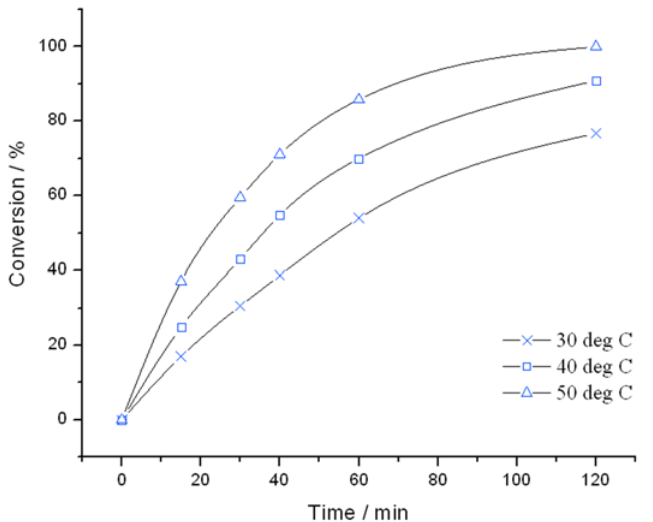
Figure 1. Time online analysis of allyl alcohol epoxidation with TS-1. Reaction conditions: [allyl alcohol] = 0.5 M, [H 2 O 2 ] = 0.25 M, mass TS-1 = 50 mg, various temperatures.